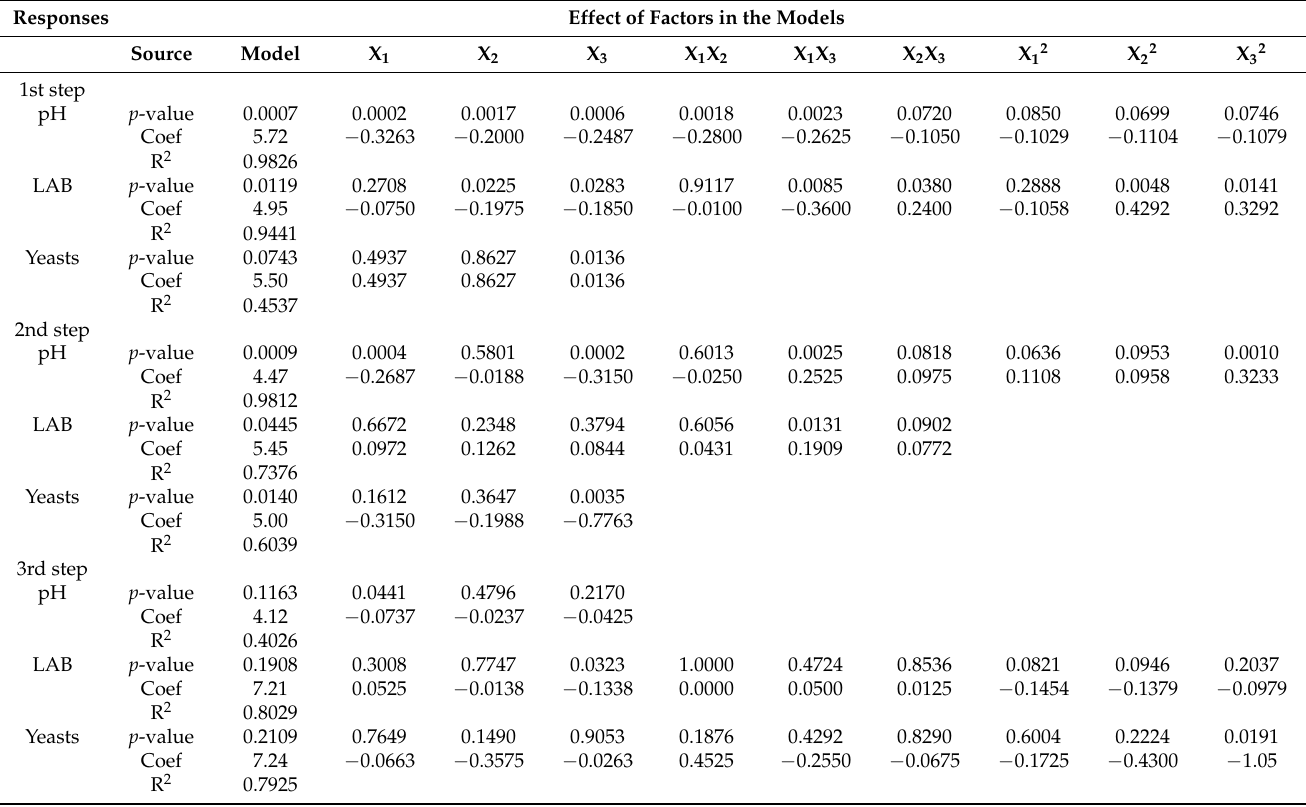
Table 3. Analysis of variance of the